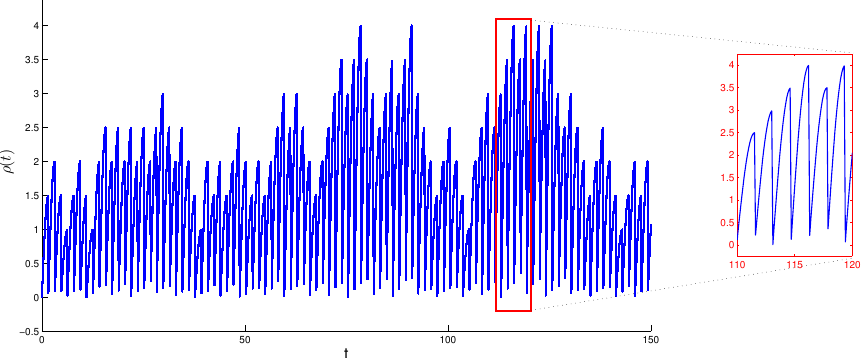
Figure 5. The graph of the piecewise continuous unpredictable function ρ ( t ) = X n sin ( t -0.5 n π ) , t ∈ [ hn , h ( n + 1 )) , n = 0,1,2, . . . The vertical lines are drawn for better